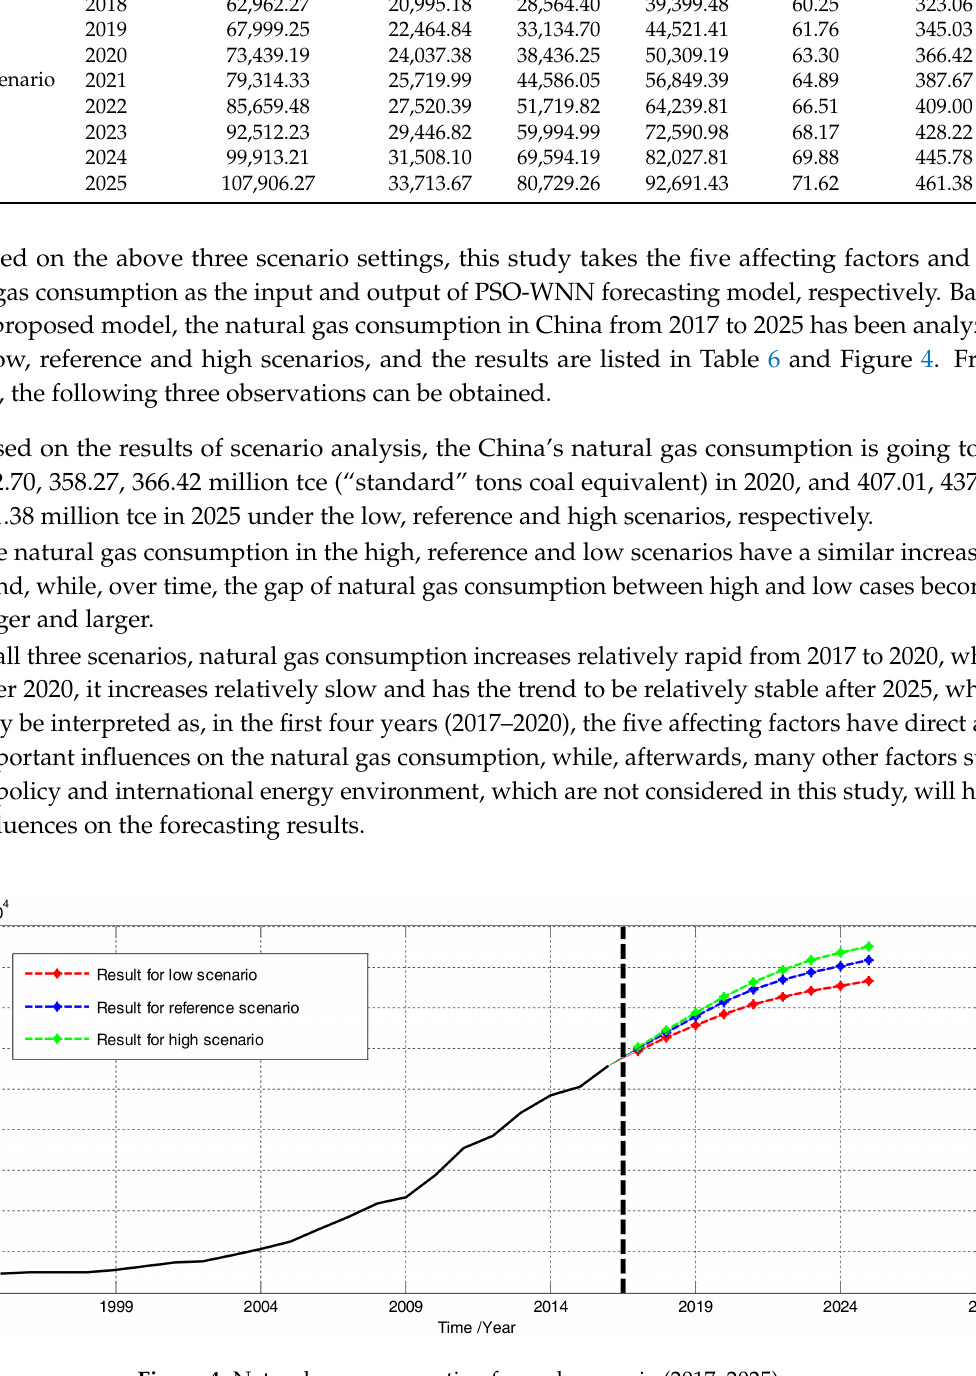
Figure 4. Natural gas consumption for each scenario